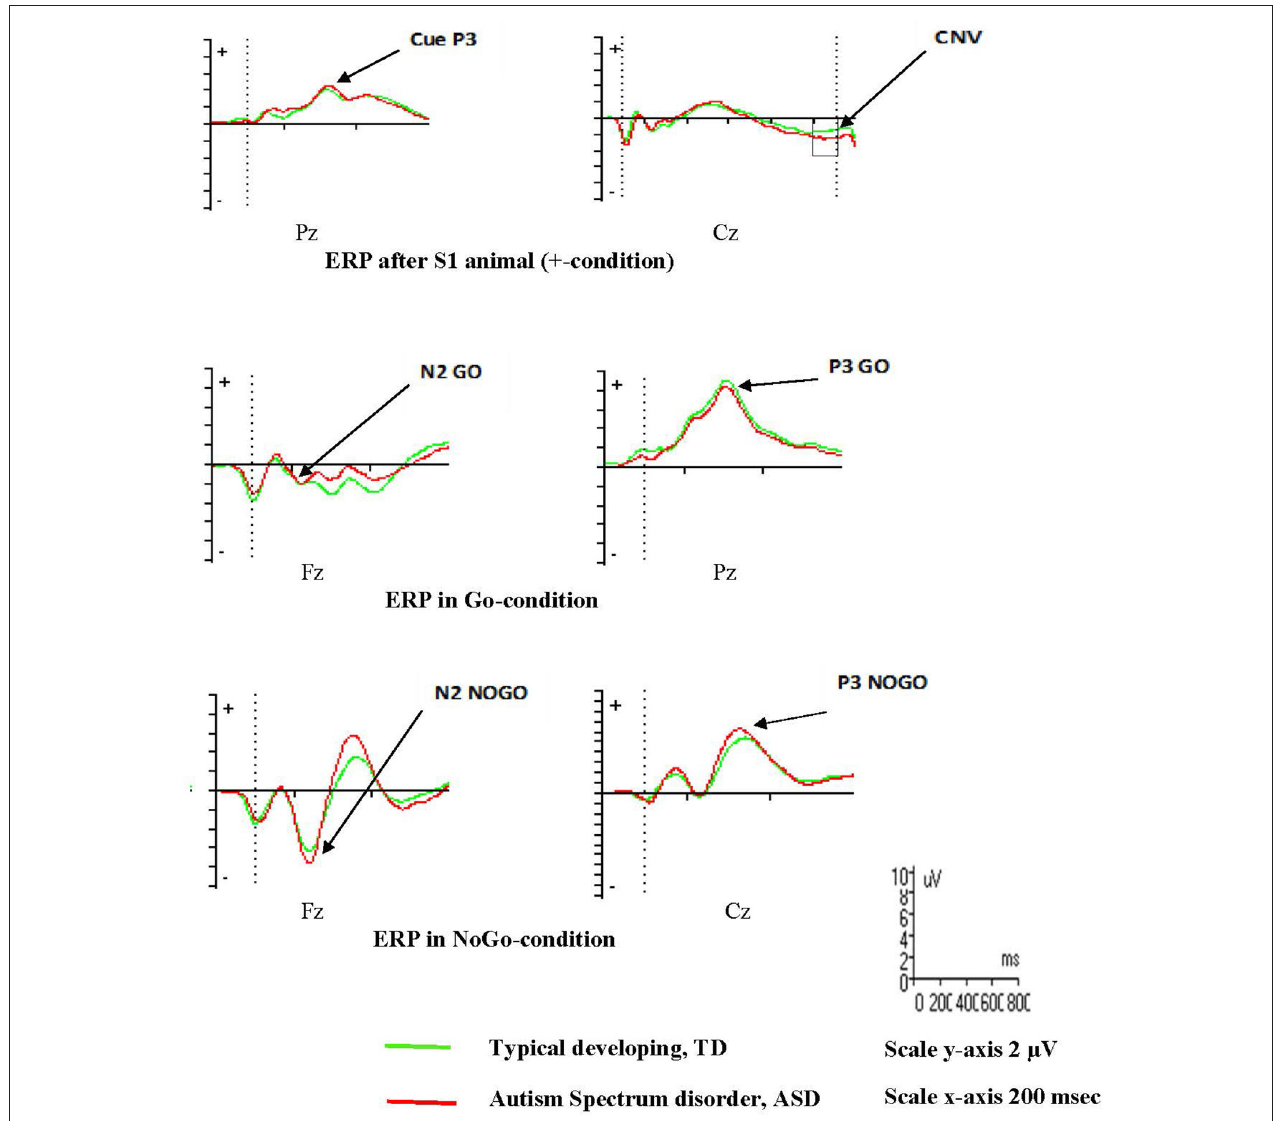
FIGURE 2 | Event Related Potentials, ERPs, VCPT adolescents 16 years and